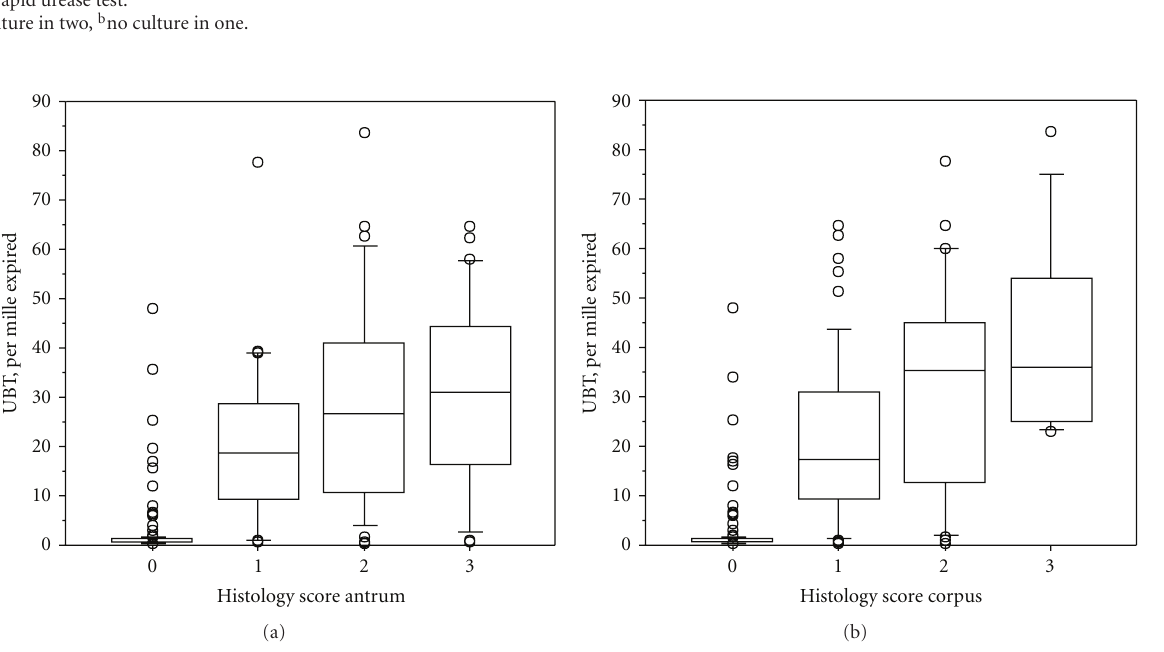
Figure 1: Boxplots (showing median and interquartile ranges) of the relation between UBT (per mille) and histological score of H. pylori